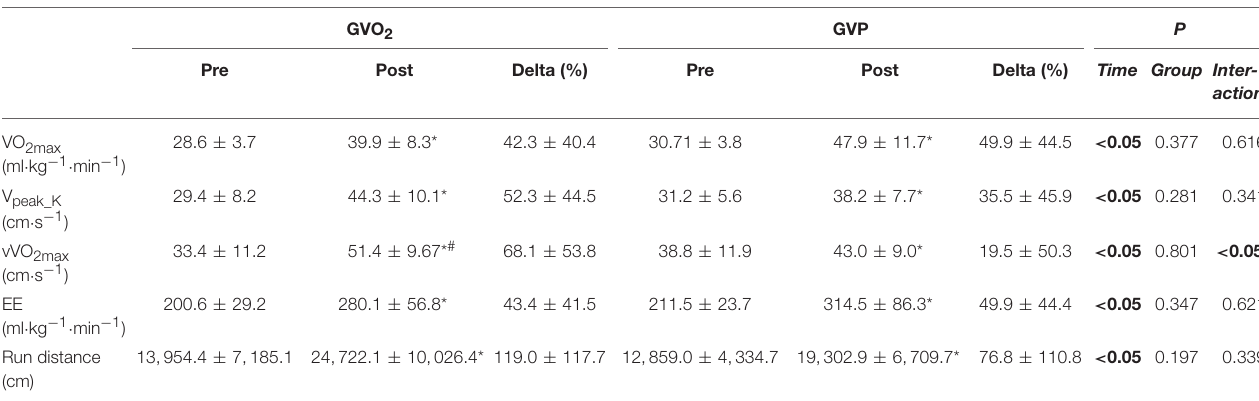
TABLE 2 | Pre- and post-training VO 2max , V peak_K , vVO 2max , EE and run distance.